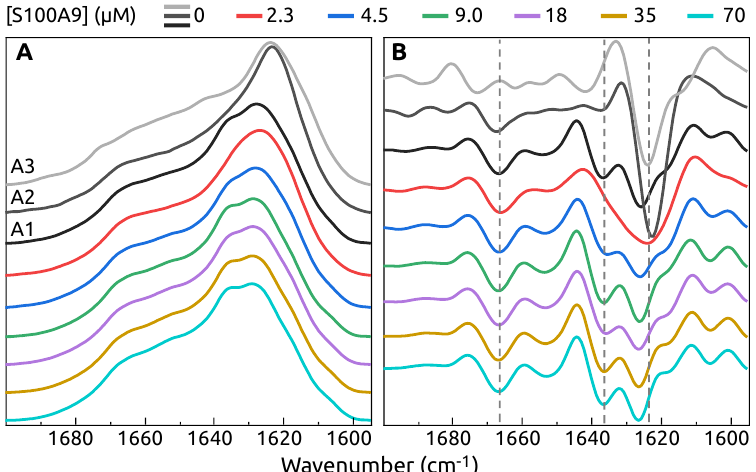
Figure 2. FTIR spectra ( A ) and the second derivatives ( B ) of fibrils obtained after α -syn aggregation with different concentration of S100A9: 0.0µM, 2.3µM, 4.5µM, 9.0µM, 18µM, 35µM, 70µM. The spectra and second derivatives of α -syn fibril populations are indicated by A1, A2 and A3. Concen- tration of S100A9 is color coded. Fibrils formed in PBS buffer, 50µM ThT, 0.02% NaN 3 , 300RPM at 37°C for